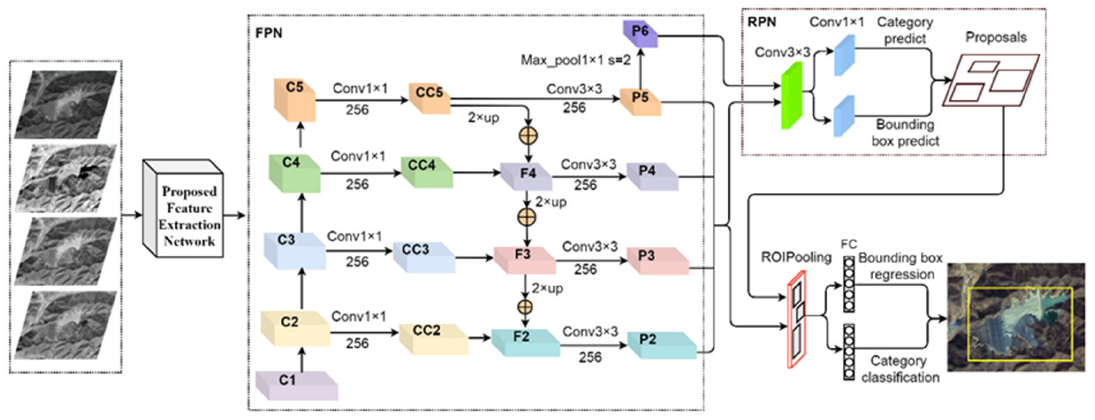
Figure 3. Proposed optimized network structure.